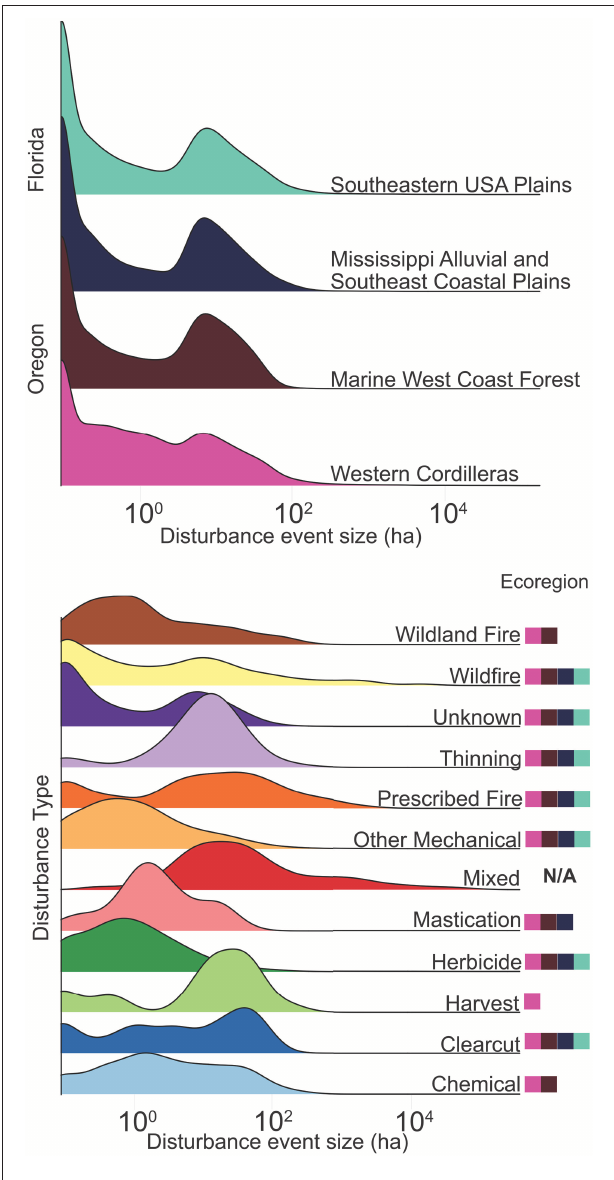
FIGURE 9 | Size density plots showing the contrasts between ecoregion/state and disturbance type. Colored boxes next to disturbance size density curves show what ecoregion contains the respective disturbance. Sample sizes associated with density plots can be found in Supplemental Table 1